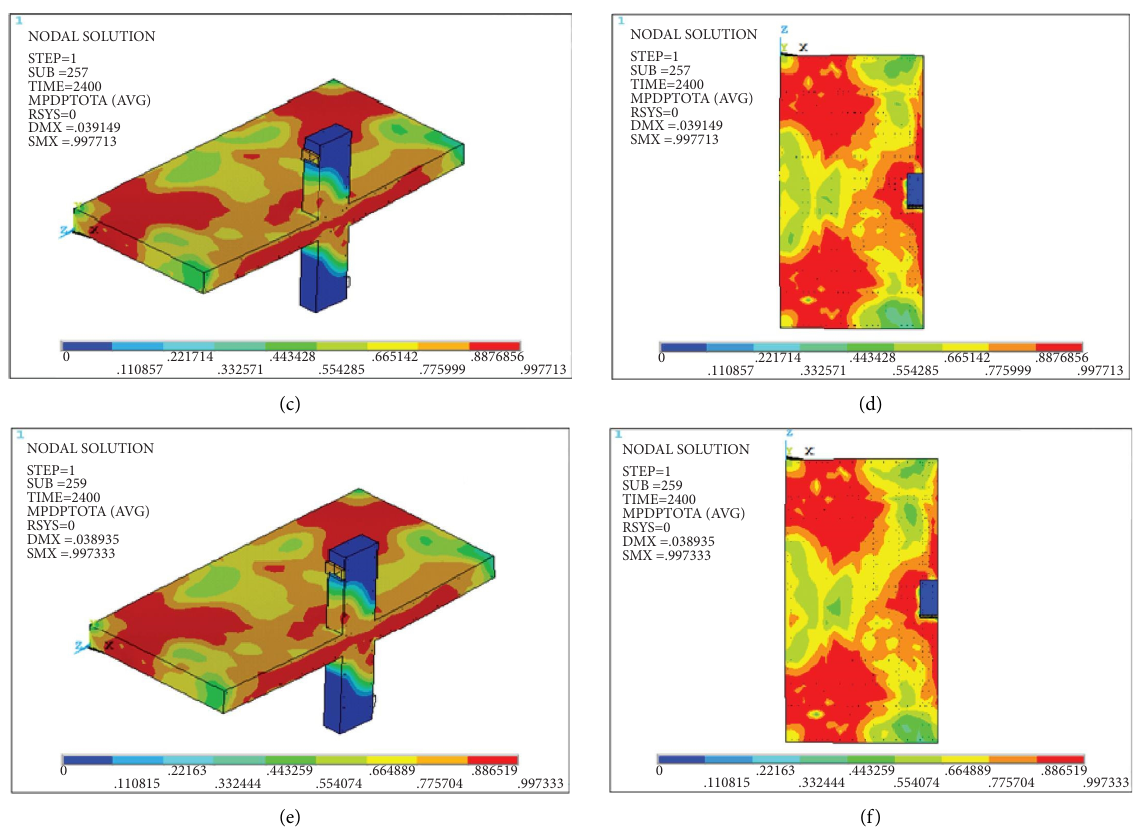
Figure 37: Concrete damage of specimens with varying concrete grade. (a) Specimen 200-25-1-ALL Bs-2400. (b) Bottom surface. (c) Specimen 200-30-1-ALL Bs-2400. (d) Bottom surface. (e) Specimen 200-35-1-ALL Bs-2400. (f) Bottom surface.